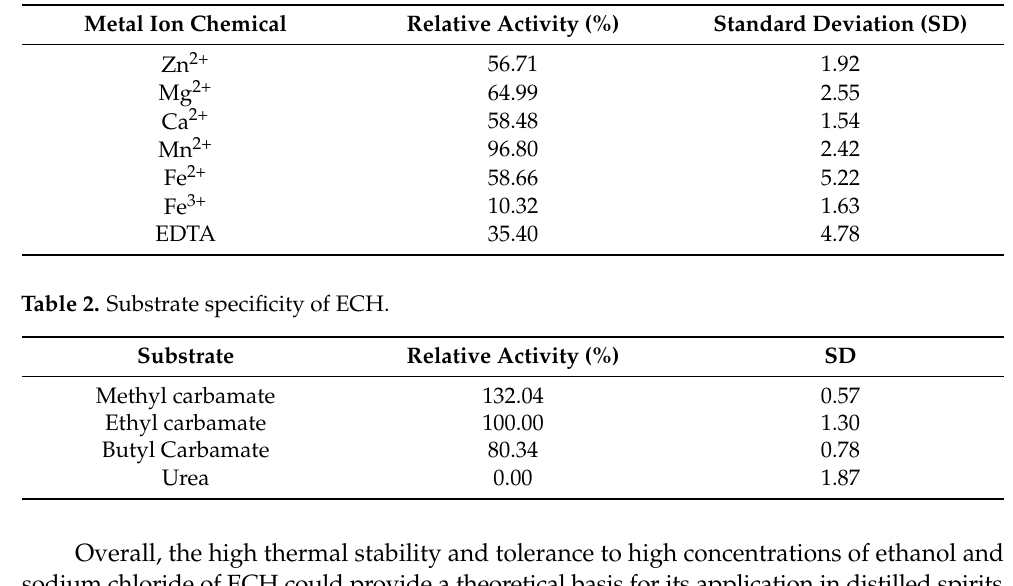
Table 1. Effect of metal cations and ethylene diamine tetraacetic acid(EDTA) on activity of ethyl carbamate hydrolase (ECH).